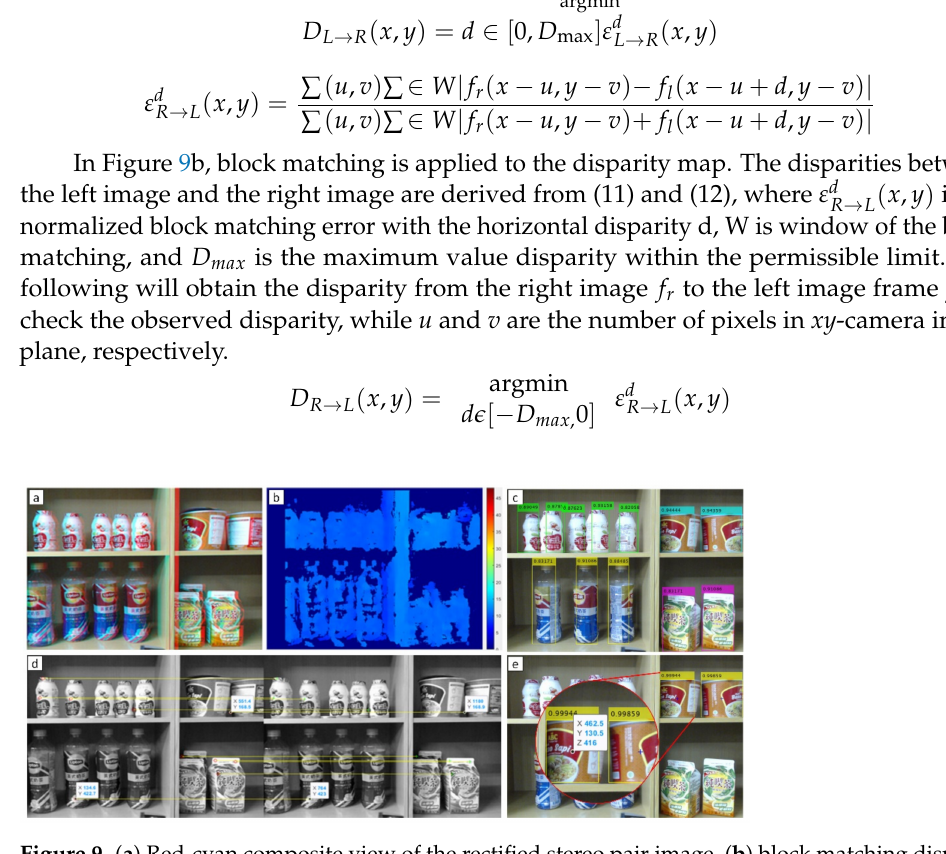
Figure 9. ( a ) Red-cyan composite view of the rectified stereo pair image, ( b ) block matching disparity map from ( a ), ( c ) confidence levels of original YOLOv2, ( d ) merger of left and right image with n = 10 matching points, and ( e ) output selected detector of modified YOLOv2 with confidence level with XYZ